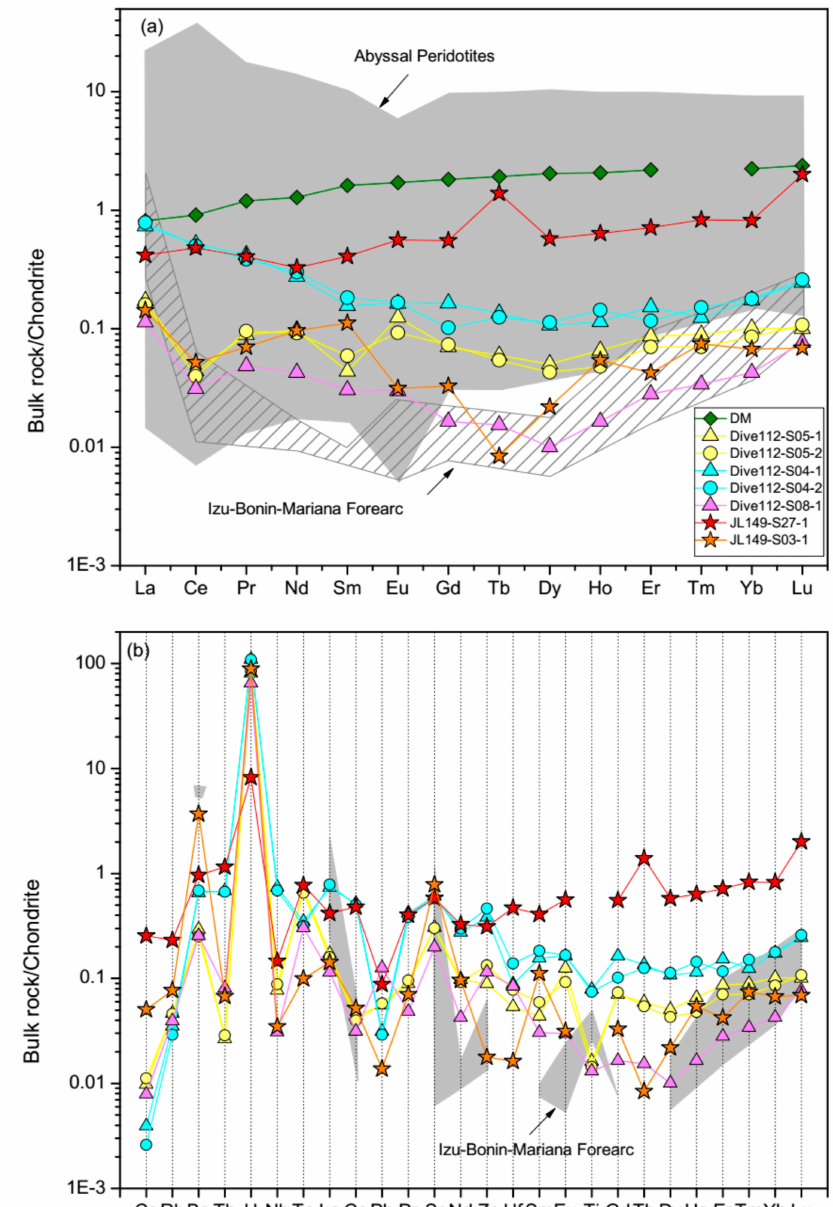
Figure 3. ( a ) Chondrite-normalized rare earth element patterns and ( b ) a trace element spider diagram of the Yap Trench peridotites. JL149 samples are from the southern Yap Trench. Chondrite values are from Anders and Grevesse (1989) [42]. Fields for the abyssal peridotites [38] and the Izu–Bonin–Mariana forearc peridotites [39] are shown for comparison. Data for the depleted mantle (DM) are from Workman and Hart (2005)